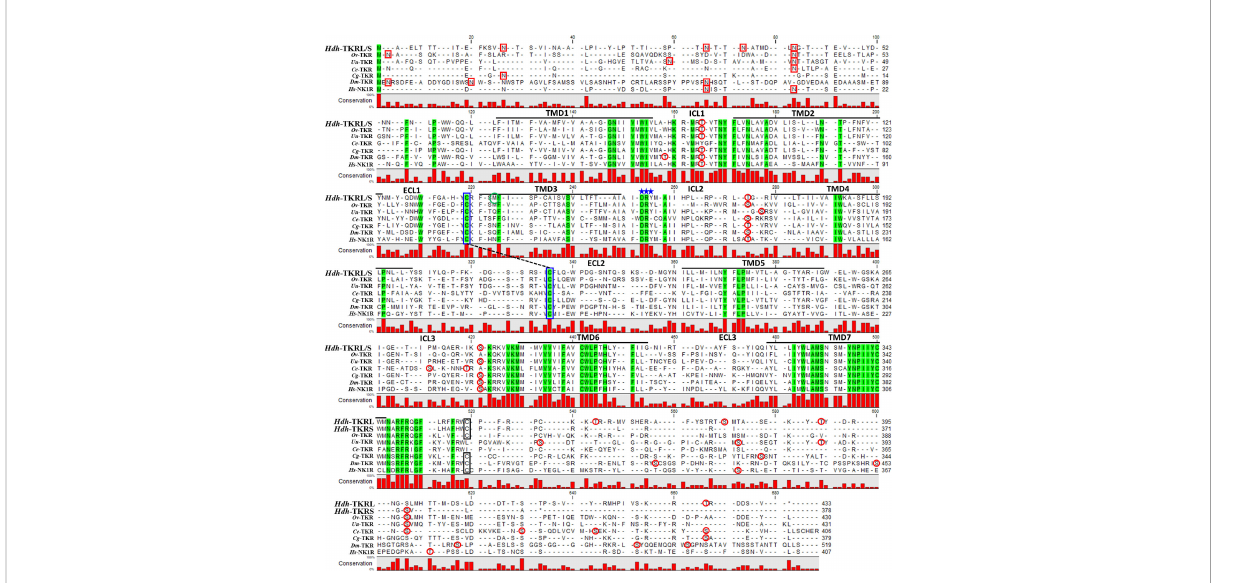
FIGURE 2 Amino acid sequence alignment of Hdh-TKRs with representative functional TKRs. The predicted seven transmembrane domains (TMD1 – 7) between intracellular loops (ICL1 – 3) and extracellular loops (ECL1 – 3) are indicated above the alignment. Amino acid residues that are common to these receptors are highlighted in green. Potential N -linked glycosylation sites, the characteristic DRY/F sequence of rhodopsin-like GPCR, and consensus PKC and PKA phosphorylation sites are denoted with red boxes, blue stars, and red circles, respectively. Conserved cysteine residues forming a disul fi de bond between ECL1 and ECL2 TMD3 are indicated by blue boxes with a dotted line. Black-boxed cysteine residues indicate the consensus palmitoylation sites. The amino acid sequences of Hdh -TKRL (NCBI accession number MW810094) and Hdh -TKRS (MW929758) were placed in a multiple alignment with those of Octopus vulgaris -TKR ( Ov -TKR: AB096700), Urechis unicinctus -TKR ( Uu -TKR: BAB87199.1), Caenorhabditis elegans -TKR ( Ce -TKR: NP_499064.2), Crassostrea gigas -TKR ( Cg -TKR: XP_022673516.1), Drosophila melanogaster -TKR ( Dm -TKR: X62711.1), and Homo sapiens -NK1R ( Hs -NK1R: